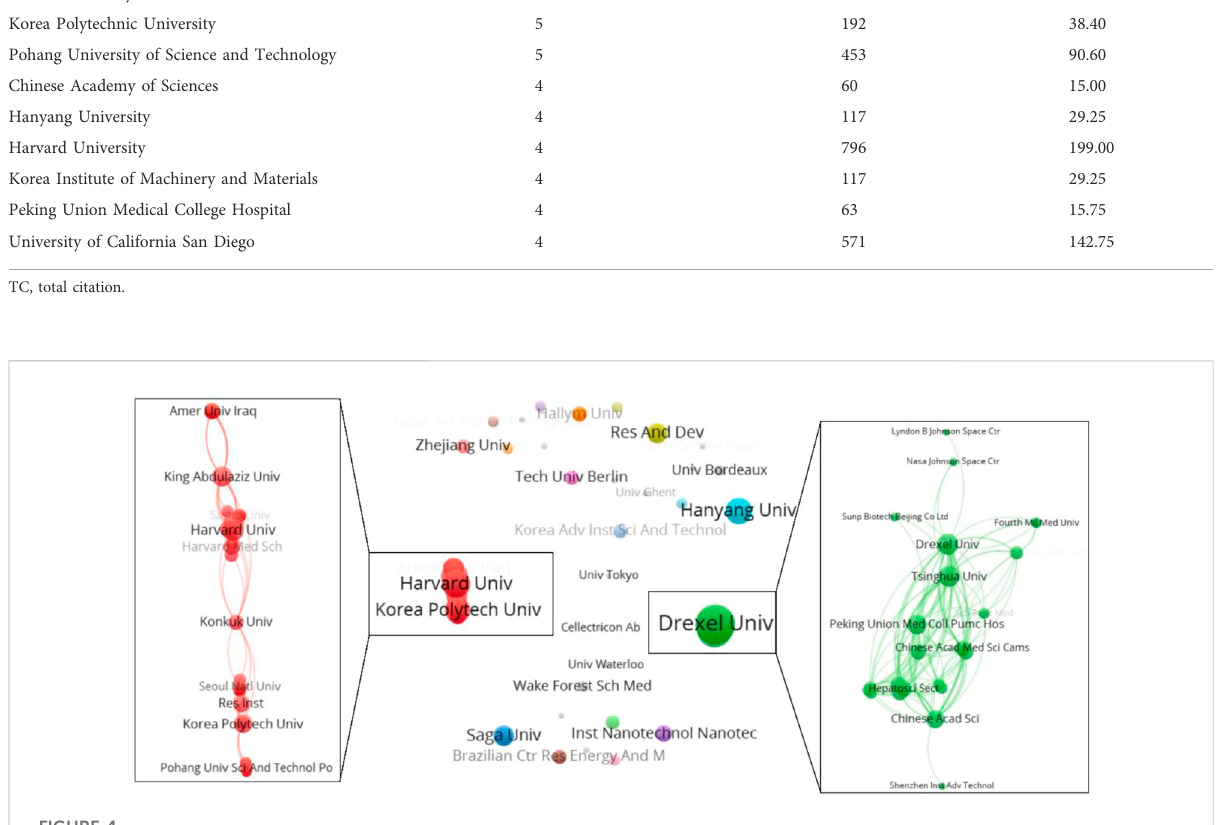
FIGURE 4 The cooperation relationship of institutions that published